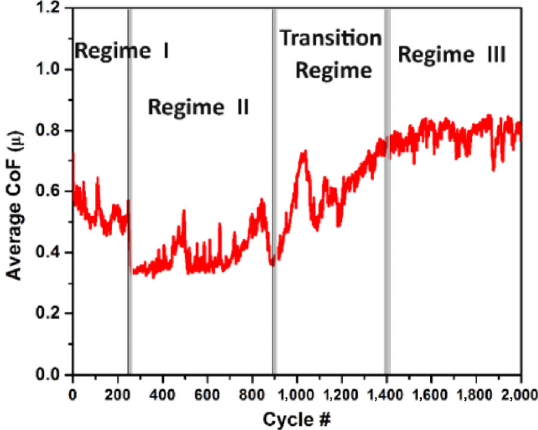
Fig. 3 Average CoF vs. cycle # at 390 MPa contact stress and RH 60 indicating four regimes in tribological